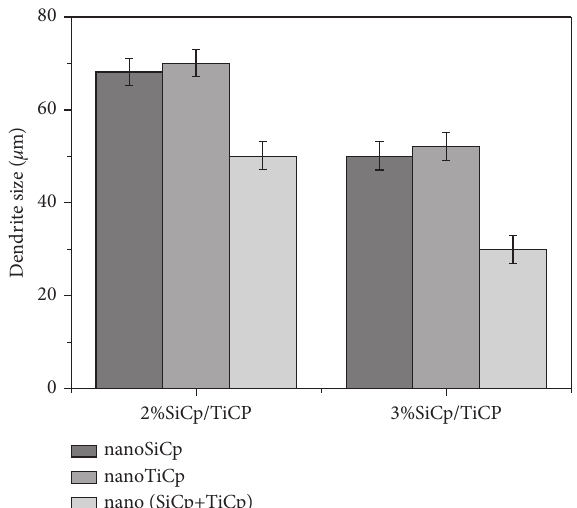
Figure 7: The dendrite size of α -Al in hybrid nano-(SiCp +TiCp)/Al composites.